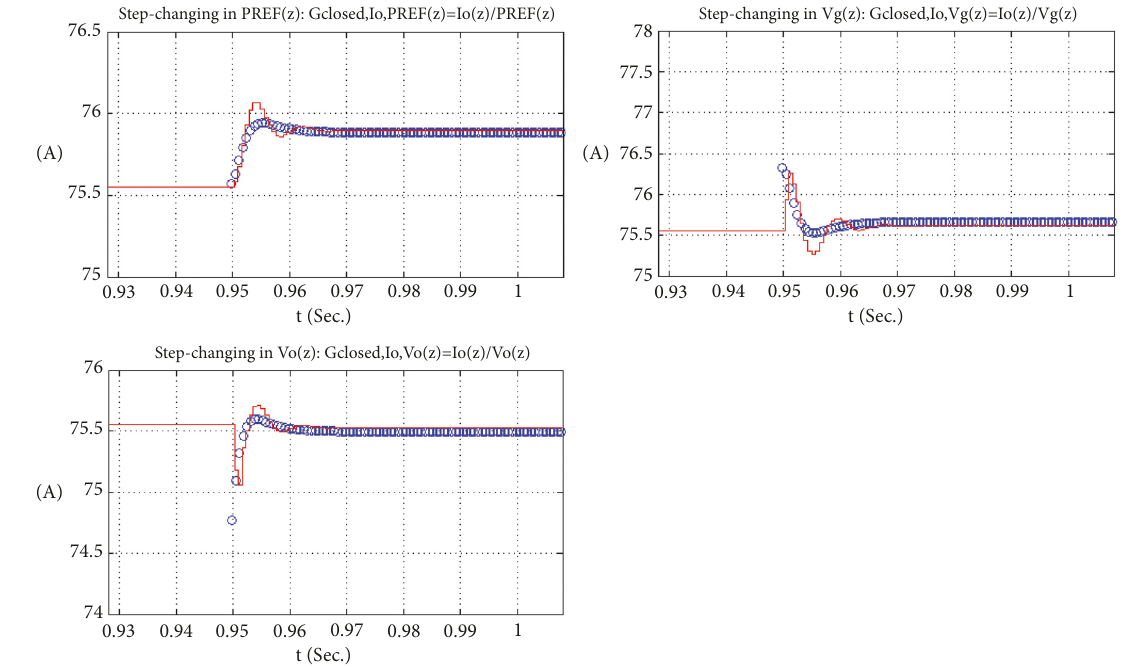
Figure11:Dynamicsofoutputcurrent I generatedbyboththeswitchingmodelandderivedstate-spacemodelwiththeclosed-loopcontroller o when +0.5% of step-changing is applied in P , V , and V , respectively ( P : 7.5MW 󳨀→ 7.5375MW, V REF g o REF 󳨀→ 100.5kV 100.0kV ; blue circle: dynamic of state-space model in z-domain, red line: dynamic of electrical signal in PLECS circuit DC DC model, the interrupt time of digital controller: T =1/( 2 x 𝑓 푠 | ) =1/(2x750Hz) op int